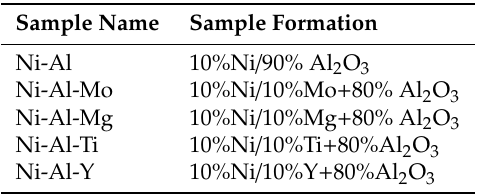
Table 3. Designations of the catalysts used in this